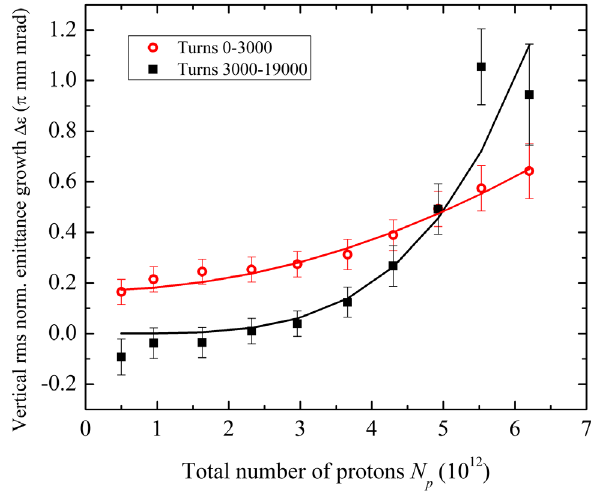
FIG. 14. Vertical rms emittance growth vs N p : (red circles) over the first 3000 turns; (black squares) from 3000 to 19000 turns. The data points are calculated for the IPM emittance values averaged over 500 turns 0 – 500, 3000 – 3500, 19000 – 19500. The error bars indicate estimated statistical uncertainty. Red and black solid line are for the approximations Eqs. (8) and (9), respec-